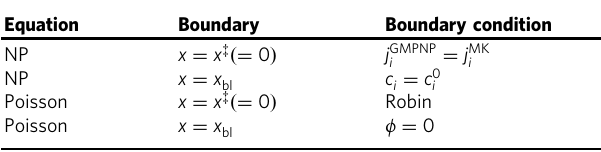
Table 1 Boundary conditions used for the solution of the GMPNP